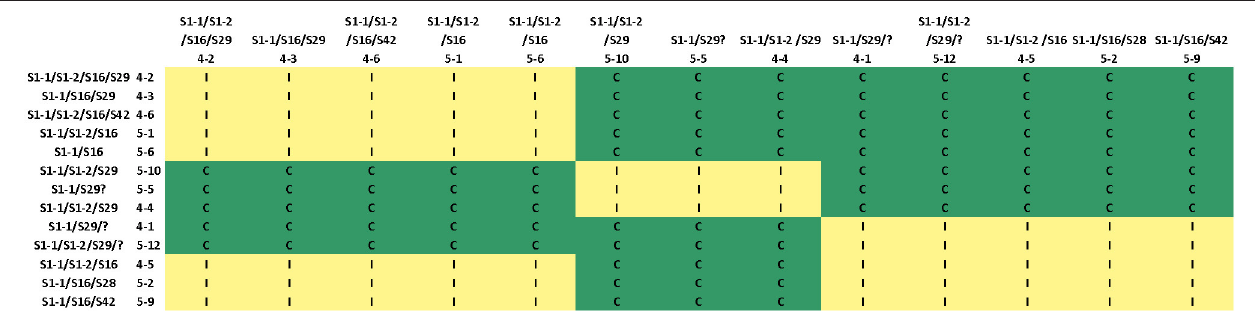
FIGURE 3 | Segregation analysis for the cross A1 × C2, based on combined genotypes from the direct sequencing of SRK 01 and from 454 pyrosequencing based on genotyping of other alleles found in the crosses. The cross was between two different tetraploid A. lyrata populations in Austria that were thought to be outside of the hybrid zone with A. arenosa . The predicted genotype of the donor is indicated along the top row and that of the recipient in the column to the left. Incompatible cross combinations are indicated with an I (and shaded yellow), compatible combinations with C (and shaded green). Comparison of segregation of SRK haplotypes with the phenotype suggests that: S16 is expressed with all other haplotypes; it appears to be codominant with S42 in stigmas but recessive in pollen. S29 is recessive to S16. Individuals 4-1 and 5-12 must have an allele that has not been identified because they show different patterns of compatibility than 5-10, 5-5, and 4-4, which also only have S1-1 and S29. S28 was only found in three individuals and only one (5-2) was included in the analyses shown here; based on the 454 genotyping it can be difficult to distinguish S18, S28, and S29 so this could be an error in assignment. Individual 5-5 must have S29 but it was not detected in the 454 analyses.